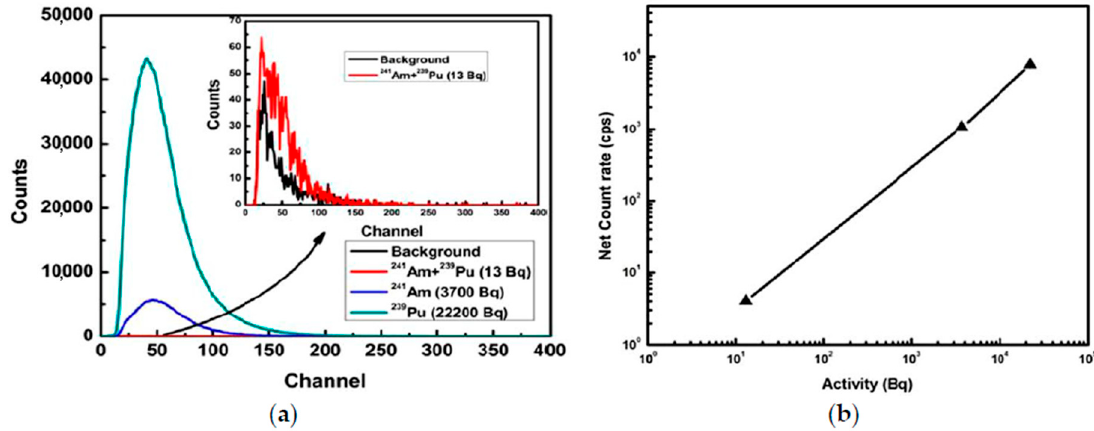
Figure 34. ( a ) Pulse height spectrum for different α sources and ( b ) net count rate versus activity for α sources [101].